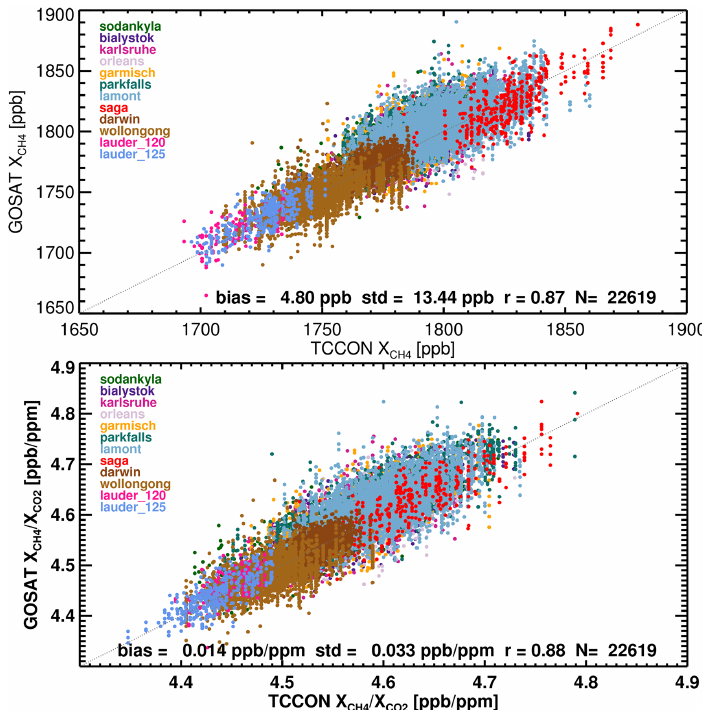
Figure 3. Correlation plot of the Proxy XCH 4 (top) and the XCH 4 / XCO 2 ratio (bottom) data against TCCON ground-based FTS data at 11 TCCON sites. The overall bias, standard deviation (single-sounding precision), correlation coefficient, and total number of soundings are provided. Note that the Lauder TCCON station upgraded the instrument from a Bruker 120 to a Bruker 125 in February 2010 and these two data sets are displayed separately.